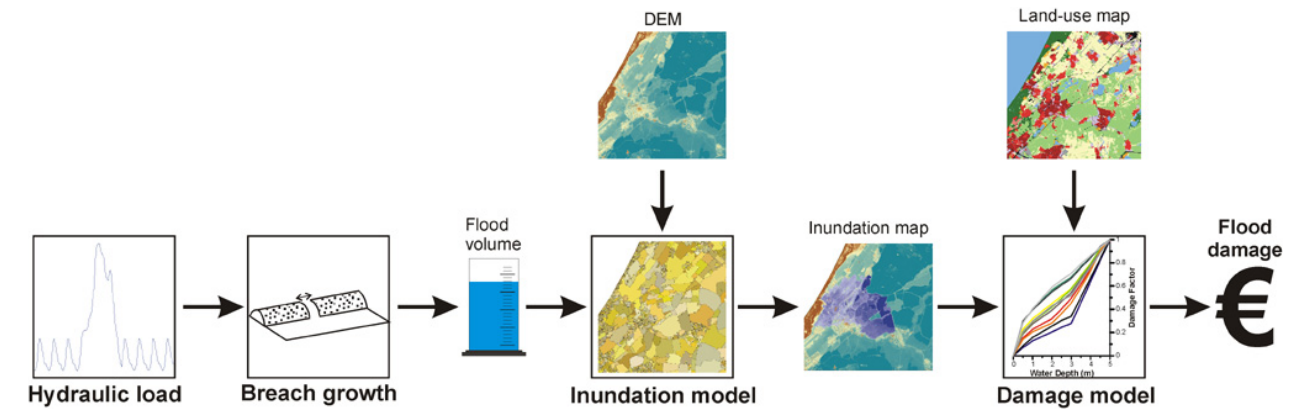
Fig. 2. Schematic representation of the modelling chain used in this